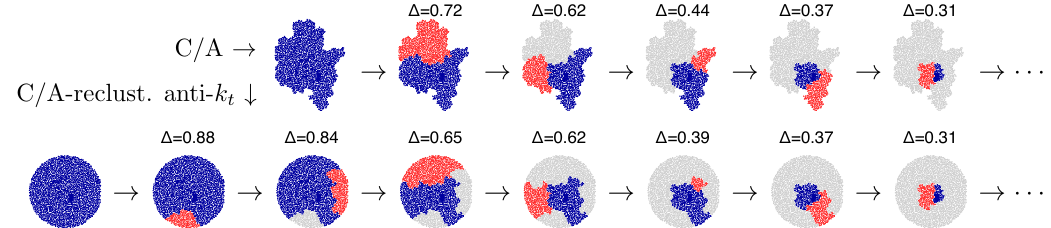
Figure 13. Illustration of declustering sequences for a Cambridge/Aachen jet (upper row) and the same neighbourhood of an event clustered with the anti- k t algorithm and subsequently reclustered with Cambridge/Aachen (lower row). The jets include ghost particles [94, 95] so as to illustrate the area of the jets involved at each declustering stage. The plot shows each stage of the declustering, with the softer subjet shown in red ( b in the notation of section 2.1) and the harder subjet shown in blue ( a